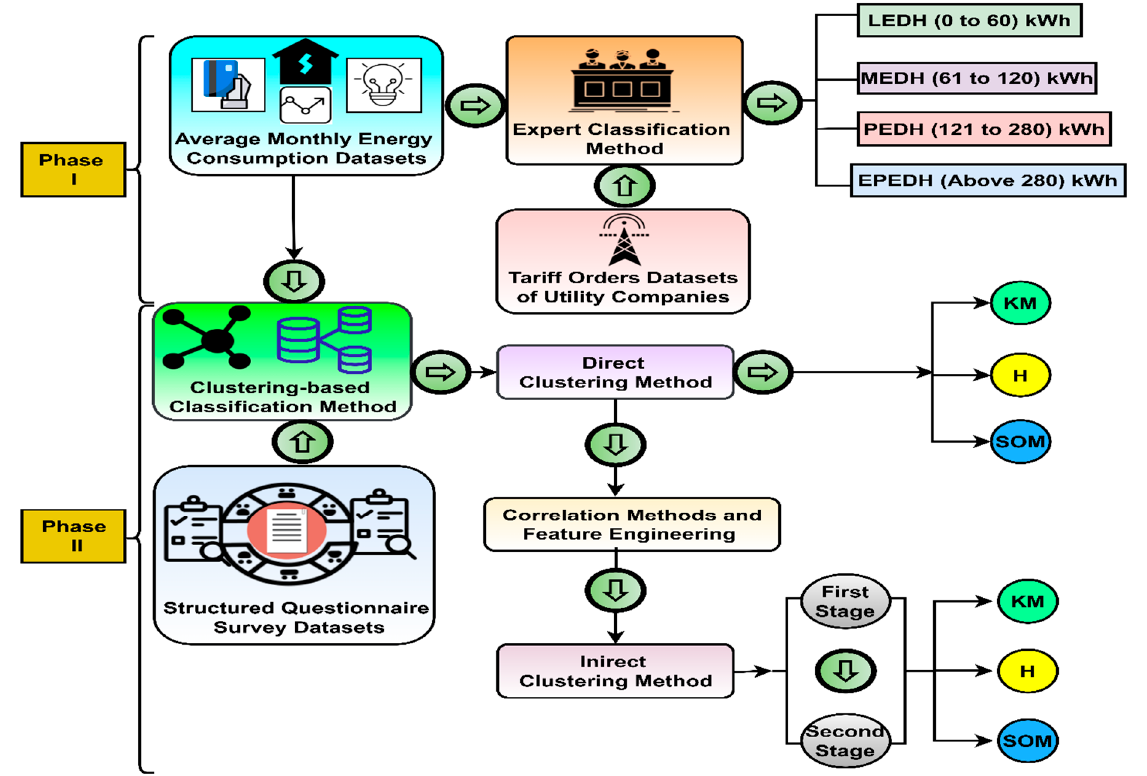
Figure 5. The input–output-based structure of the proposed work.